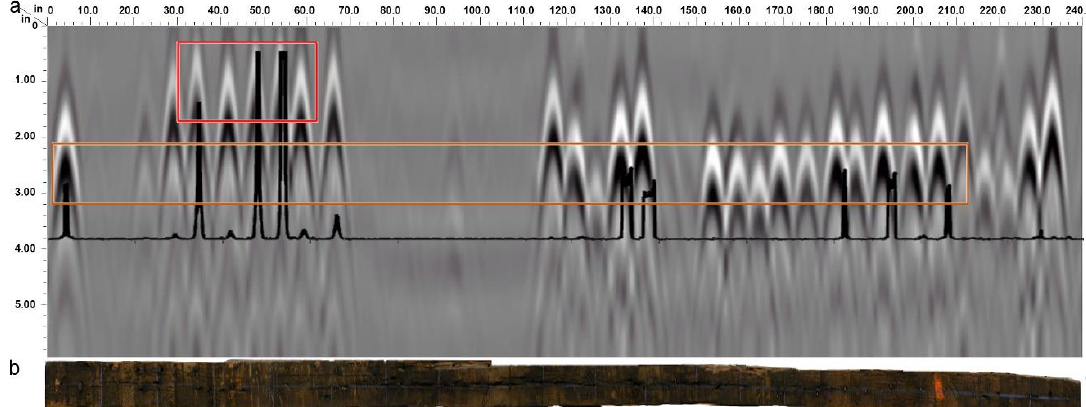
Figure 12. One B-Scan image of No. 6 timber.